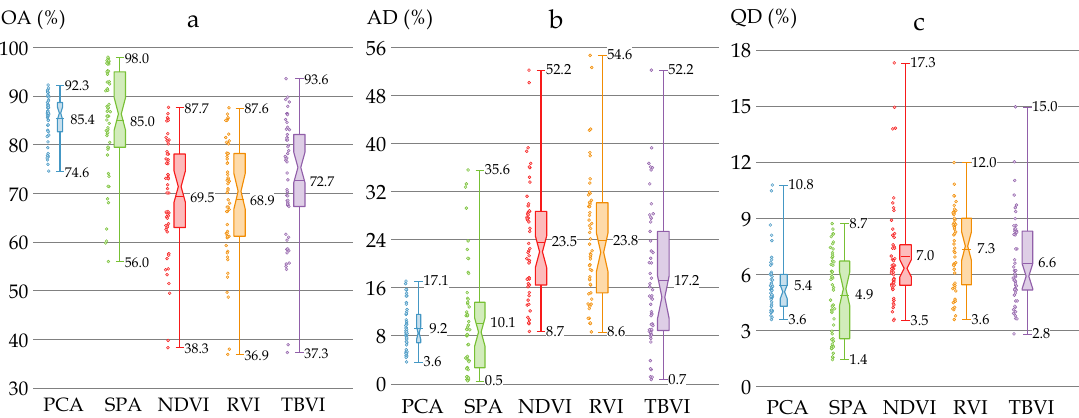
Figure 7. The box plots of the OAs ( a ), ADs ( b ) and QDs ( c ) of the 270 models using PCA, successive projections algorithm (SPA), normalized difference vegetation index (NDVI), ratio vegetation index (RVI), and three bands vegetation index (TBVI). Each box has three whisker labels representing the maximum, mean, and minimum values for each dataset from top to bottom. The box width represents SD and a comparatively wider box width indicates a larger SD value.